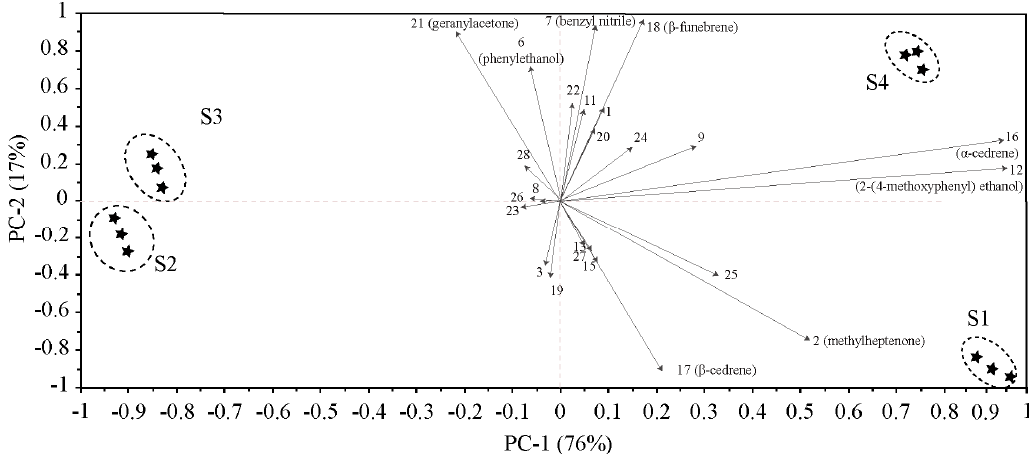
Figure 2. Principal component analysis (PCA) biplot based on the volatile compounds released from M . ioensis “Prairie Rose” flowers during flowering, showing correlations with volatile compounds (numbers correspond to those in Table 1). S1 bud stage; S2 initial flowering stage; S3 flowering stage; and S4 end of flowering stage.